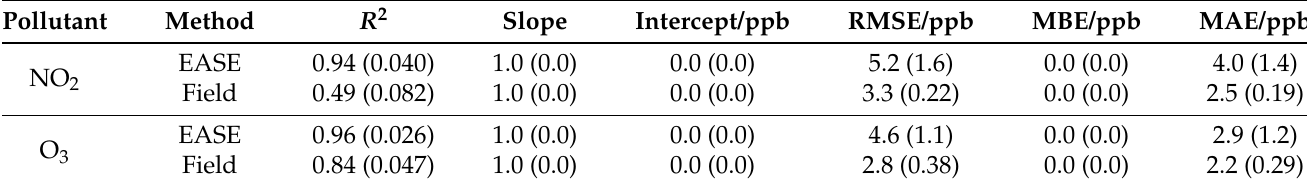
Table A6. Evaluation statistics for training of the EC nodes with all of the calibration methods. Laboratory coefficients were not available from the calibration performed by the manufacturer. Note that the Field training period encompassed low NO 2 concentrations, near the LOD, resulting in a low R 2 value. All values are means over all EC nodes with their corresponding standard deviation shown in